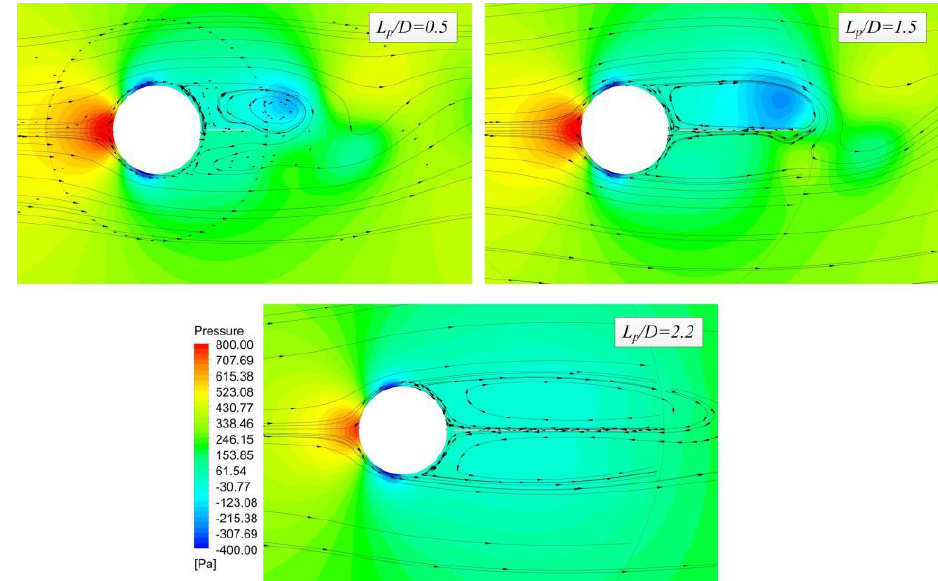
Figure 9. Pressure contours and streamlines for three different fixed plates.